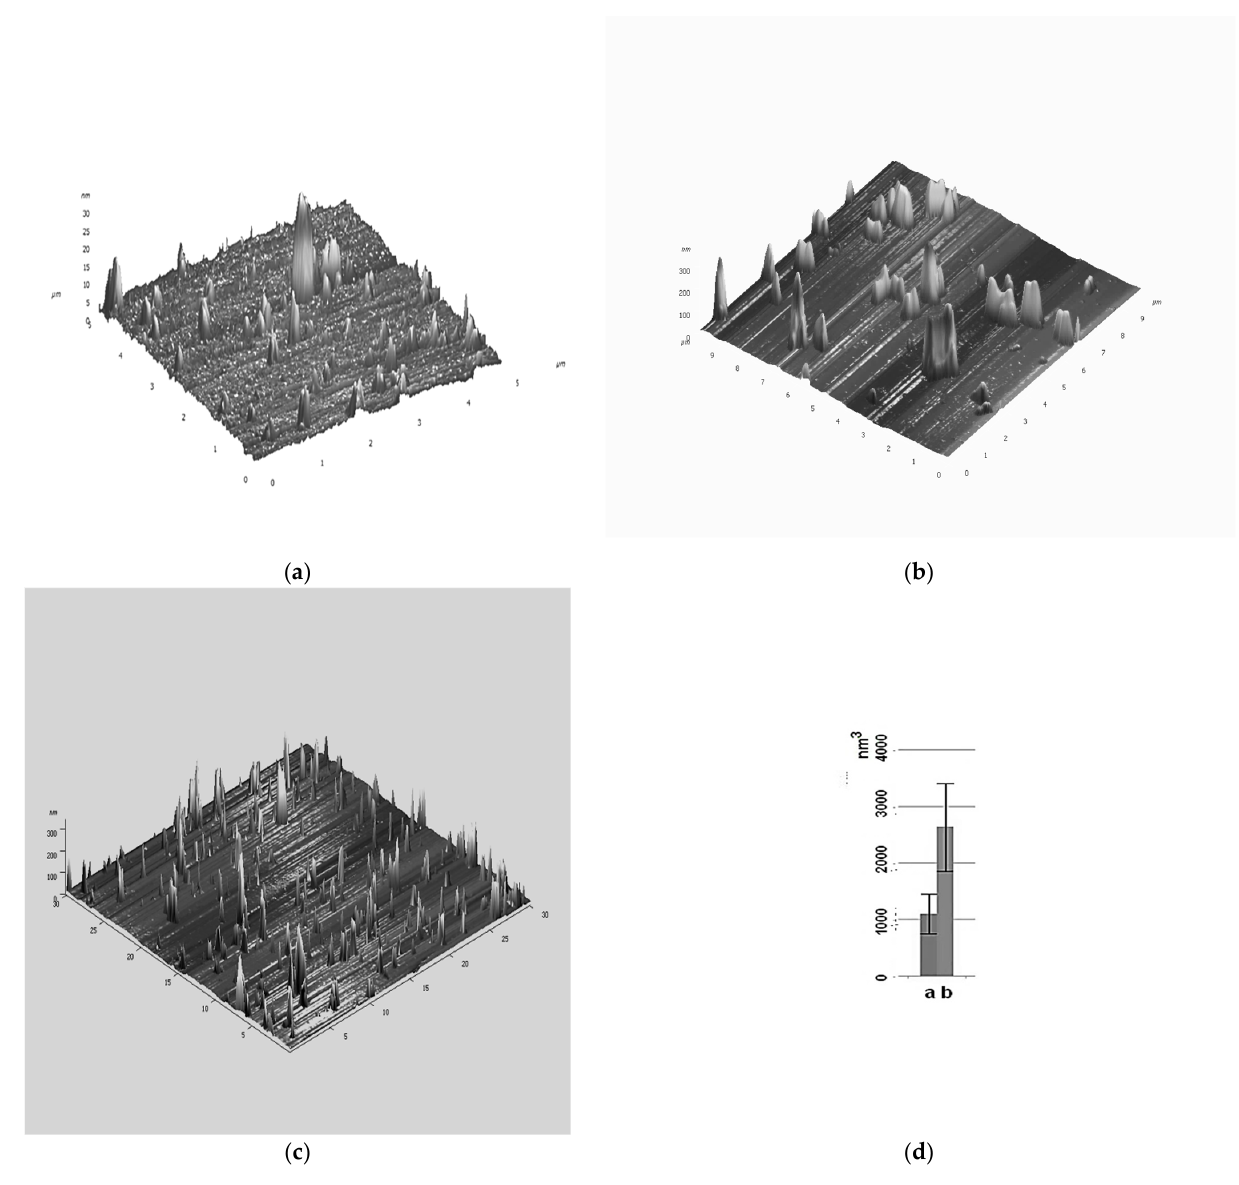
Figure 4. AFM three-dimensional images of structures formed on a modified silicon surface ( a ) based on complexes {Ni(acac) 2 ∙ HMPA ∙ PhOH} with h~12–30 nm, and ( b , c ) {Ni(acac) 2 ∙ NaSt ∙ PhOH} with h~300 nm. ( d ) Diagram of the average particle volumes based on: a-{Ni(acac) 2 ⋅ His}, b-{Ni(acac) 2 ⋅ His ⋅ Tyr}, adapted from [16].